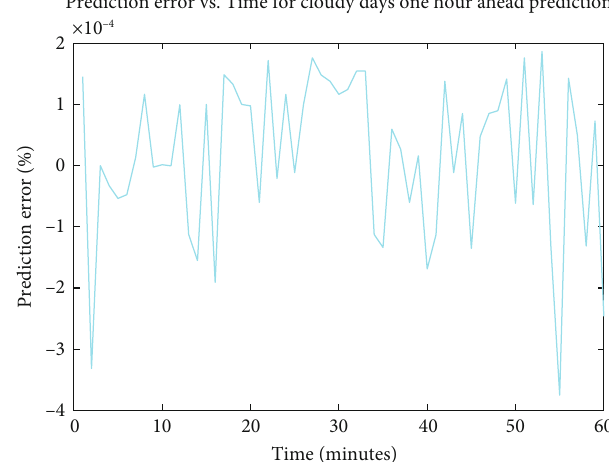
Figure 23: Prediction error vs. time for cloudy day one-hour-ahead prediction.